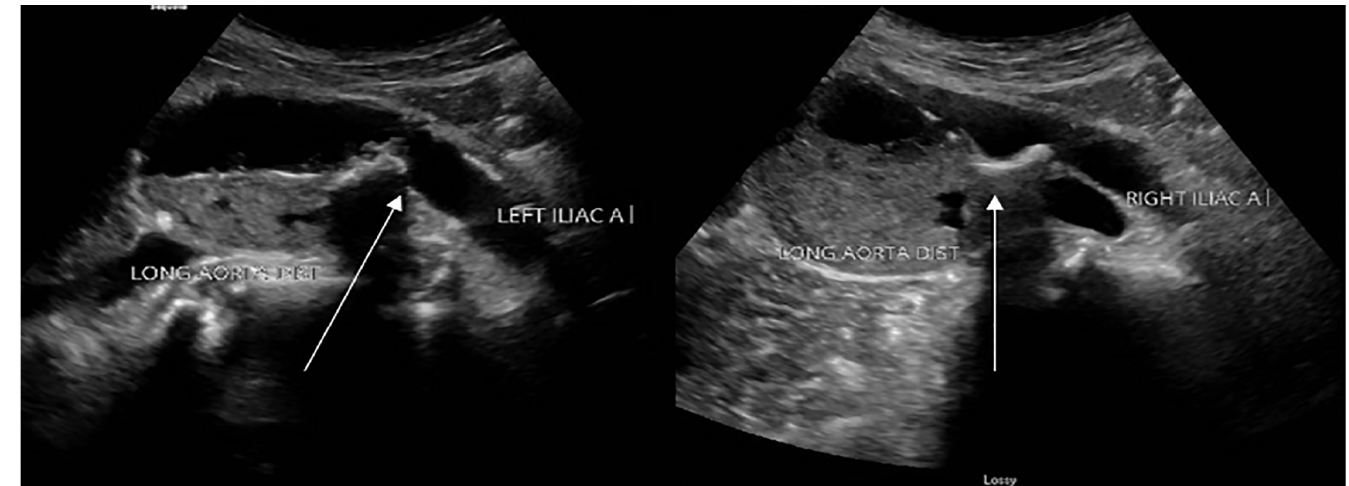
Image 2. Point-of-care ultrasound of abdominal aortic aneurysm using 3.5 megahertz probe, showing side-by-side comparison in transverse view of the aorta, at the level of bifurcation of the left and right iliac arteries as labeled. Dislodged clot can be seen at the level of bifurcation shown above